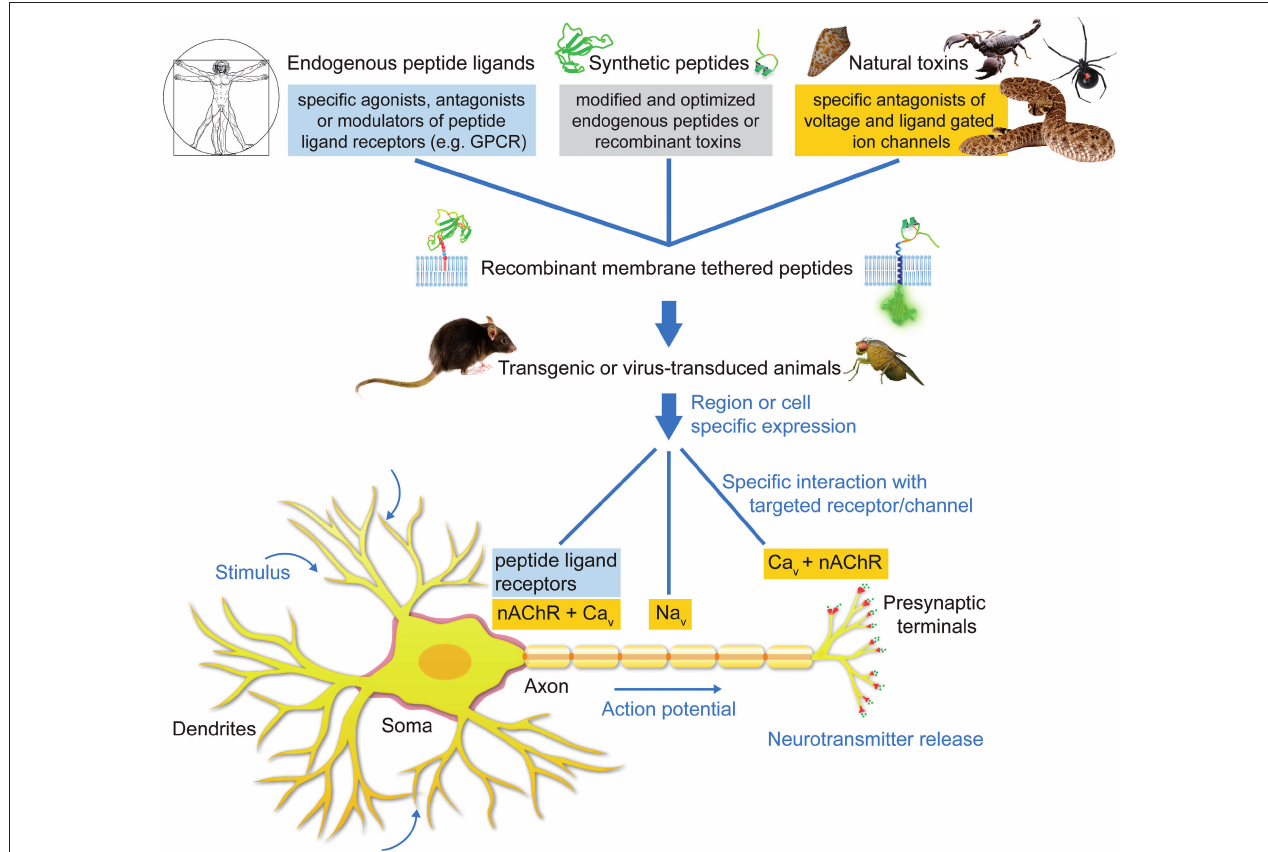
transgenic or virus-transduced animals. The t-peptide retains the specifi city of the toxin/peptide ligand allowing controlled manipulation of distinct subtypes of ion channels and receptors in a given neuronal circuit without affecting other channels/receptors in the